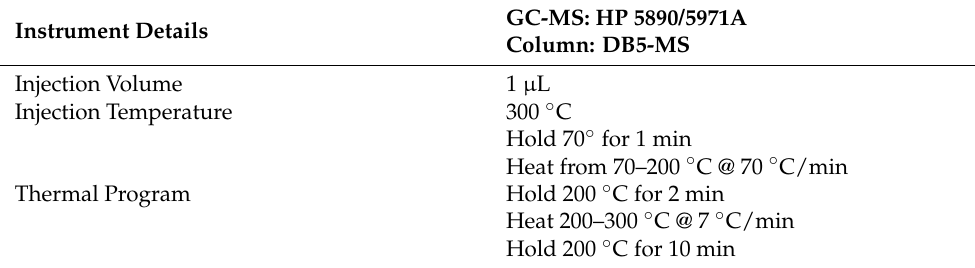
Table 3. Thermal Program GC-MS.